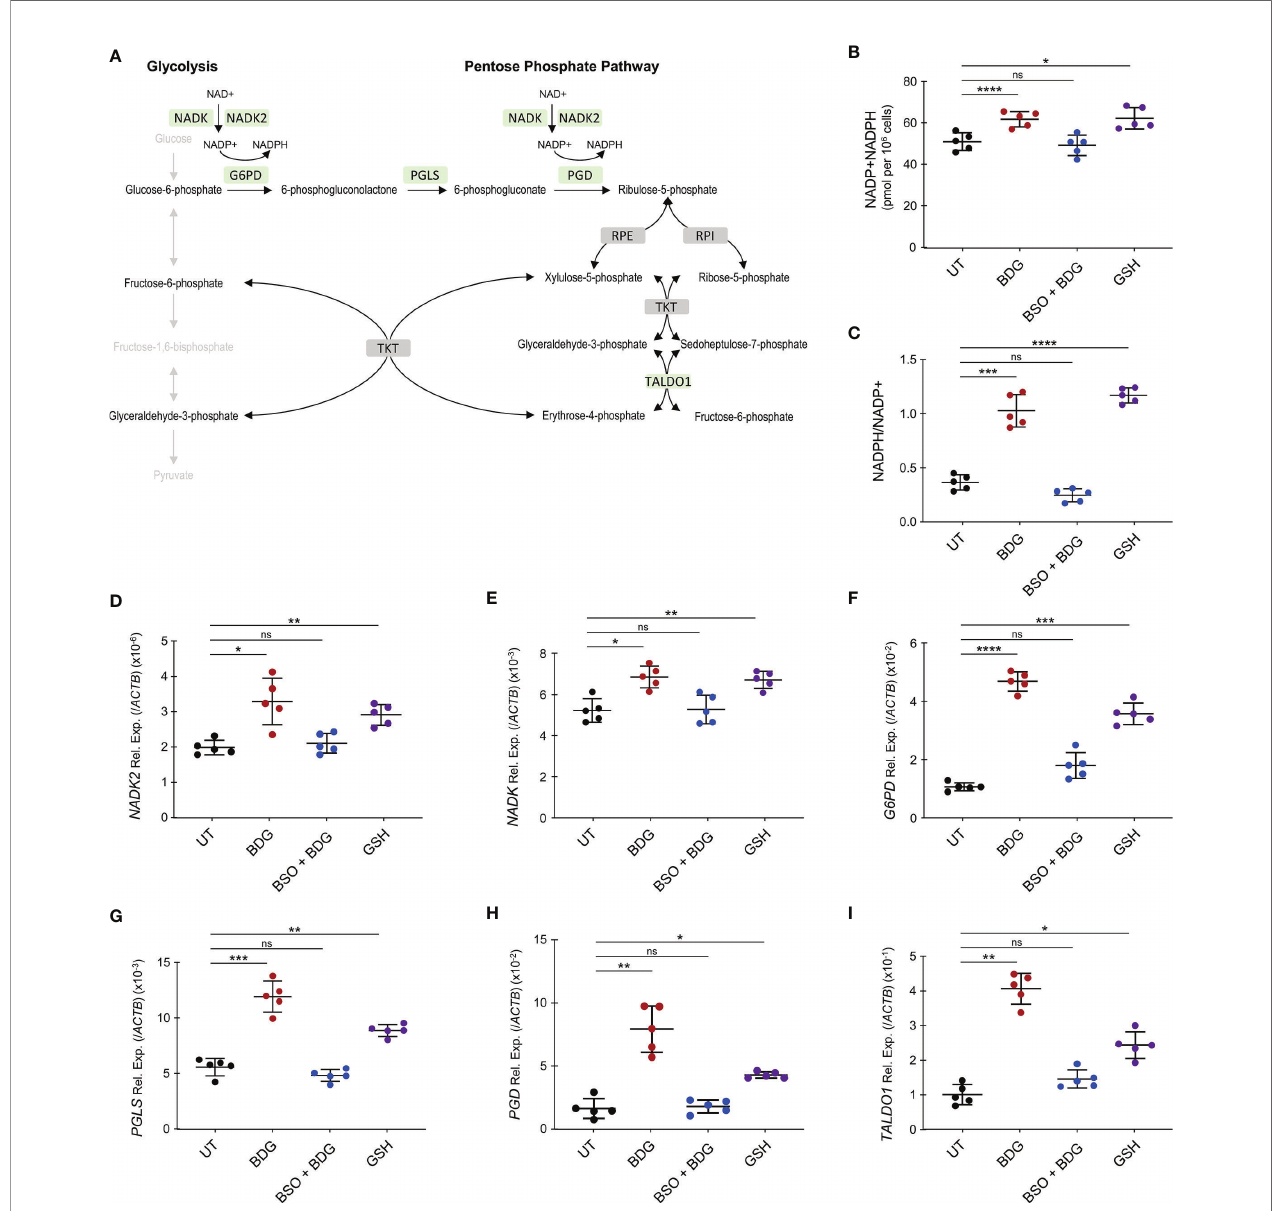
FIGURE 6 | BDG induces NADP synthesis and upregulation of the pentose phosphate pathway (PPP) in a glutathione dependent manner. (A) Schema representing PPP with genes that are signi fi cantly upregulated after BDG exposure as assessed by RNA-seq in green and genes that are not differentially expressed in grey. (B – I) Monocytes were stimulated with BDG for 24 hours, pre-treated with BSO for 24 hours and then stimulated with BDG for 24 hours, or stimulated with GSH for 24 hours and (B) total NADP+NADPH levels as well as (C) NADPH/NADP+ were measured using calorimetry. The relative expression of (D) NADK , (E) NADK2 , (F) G6PD , (G) PGLS , (H) PGD , and (I) TALDO1 were quanti fi ed using RT-qPCR. Data are presented as median ± standard deviation of n = 5 biologically independent experiments. P- values were calculated using paired one-way ANOVA with multiple comparisons. ns, not signi fi cant; * P < 0.05; **P < 0.01; *** P < 0.001; **** P <